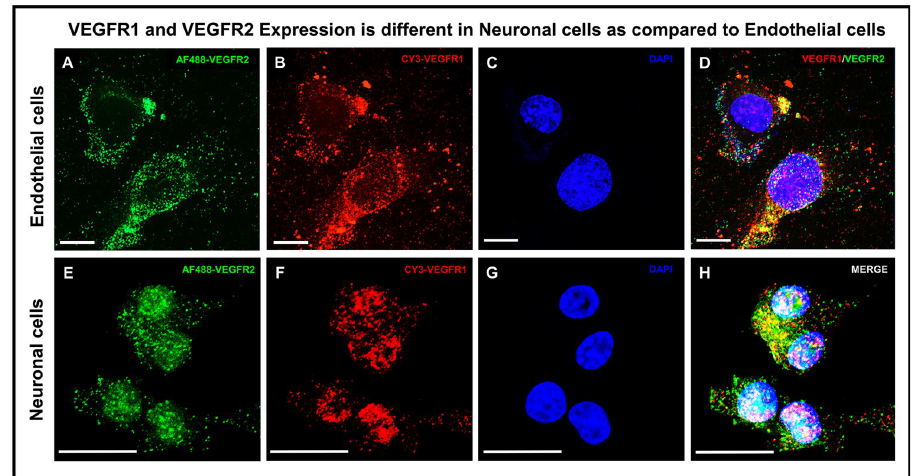
Fig 1. Confocal immunofluorescence microscopy revealed differential VEGFR expression. (A–H) A representative image of VEGFR1 co-localized with VEGFR2 in PC12 neuronal and mouse venous endothelial cells. Receptor expression was observed in both, endothelial and neuronal cells with distribution being more nuclear in neuronal cells as compared to endothelial cells. (A and E) VEGFR2 immunostaining revealed distinct receptor expression in endothelial and neuronal cells. (B and F) VEGFR1 surface immunostaining revealed punctate receptor expression in endothelial and neuronal cells. (C and G) DAPI nuclear staining. (D and H) Merging of the channels revealed co- expression of both receptors VEGFR1 and VEGFR2 in neuronal and endothelial cells. Scale bar, 10 μ m. VEGFR2 / VEGFR1 in endothelial and neuronal cells indicating higher concentration of total VEGFR2 receptors as compared to total VEGFR1 receptors is in congruence with the pub- lished literature. PC12 neuronal cells demonstrated a slightly higher VEGFR1 / VEGFR2 ratio as compared to endothelial cells. However, one should note that all these values are relative and not absolute levels of VEGFR2 and VEGFR1 total protein. Total VEGFR1 protein levels measured as a ratio of VEGFR1 protein band intensity to that of loading control, GAPDH were found to be 0.8447 ± 0.0257 A.U. (arbitrary units; Mean ± SEM; n = 3) in PC12 neuronal cells as compared to 1.276 ± 0.1982 A.U. (arbitrary units; Mean ± SEM; n = 3) in MVEC and 1.742 ± 0.1817 A.U. in MAEC (arbitrary units; Mean ± SEM; n = 3). Similarly, total VEGFR2 protein expression was found to be lower in PC12 neuronal cells (0.641 ± 0.003 A.U; arbitrary units; Mean ± SEM; n = 3) as compared to levels in MVEC (0.8037 ± 0.06809 A.U; arbitrary units; Mean ± SEM; n = 3) and MAEC (0.6890 ± 0.1180 A.U; arbitrary units; Mean ± SEM; n = 3) respectively. Fig 2B shows a relative VEGFR1 protein expression of 1.690 ± 0.3925 (Mean ± SEM; n = 3) and 2.081 ± 0.0745 (Mean ± SEM; n = 3) in MVEC and MAEC respectively in relation to PC12 neuronal cells and Fig 2C shows a relative VEGFR2 protein expression of 1.661 ± 0.5181 (Mean ± SEM; n = 3) and 1.676 ± 0.6503 (Mean ± SEM; n = 3) in MVEC and MAEC respectively in relation to PC12 neuronal cells. A one-way ANOVA between the 3 groups of cells was found to be signifi- cant for total VEGFR1 (P = 0.018) and total VEGFR2 (P = 0.0072) protein expression. Addi- tionally, relative levels or ratios of VEGFR2 to VEGFR1 were found to be lower in PC12 neuronal cells (1.370 ± 0.2614; Mean ± SEM; n = 3) as compared to levels in MVEC (2.295 ± 0.1600; Mean ± SEM; n = 3) and MAEC (2.154 ± 0.1164; Mean ± SEM; n = 3). Rela- tive levels or ratios of VEGFR1 to VEGFR2 were found to be higher in PC12 neuronal cells (0.7793 ± 0.1297; Mean ± SEM; n = 3) as compared to levels in MVEC (0.4398 ± 0.0293; Mean ± SEM; n = 3) and MAEC (0.4671 ± 0.0266; Mean ± SEM; n = 3). A one-way ANOVA between the 3 groups of cells was found to be significant for relative ratios of VEGFR2/ VEGFR1 (P = 0.0275) and VEGFR1/VEGFR2 (P = 0.0395).